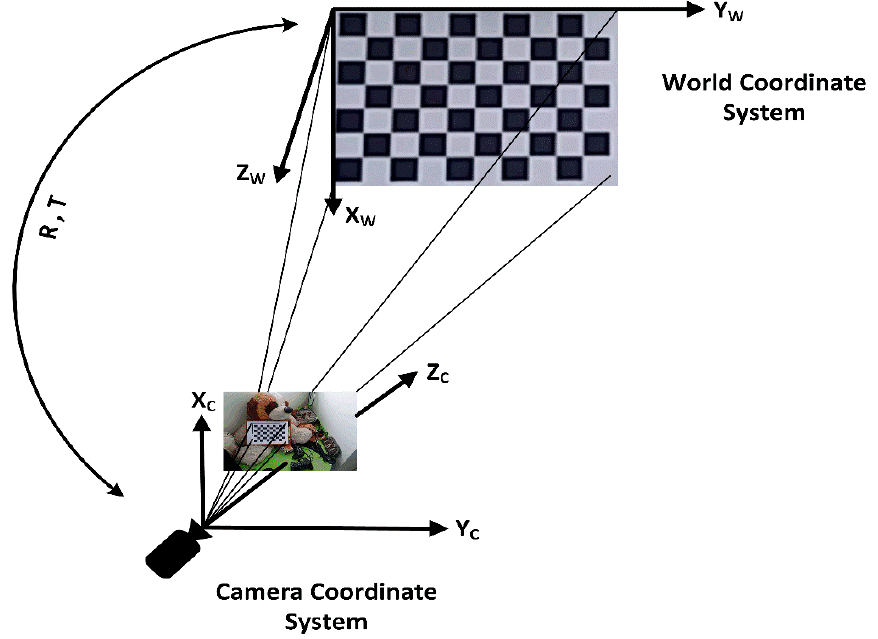
Figure 3. Definition of world and camera coordinate systems in the first image.